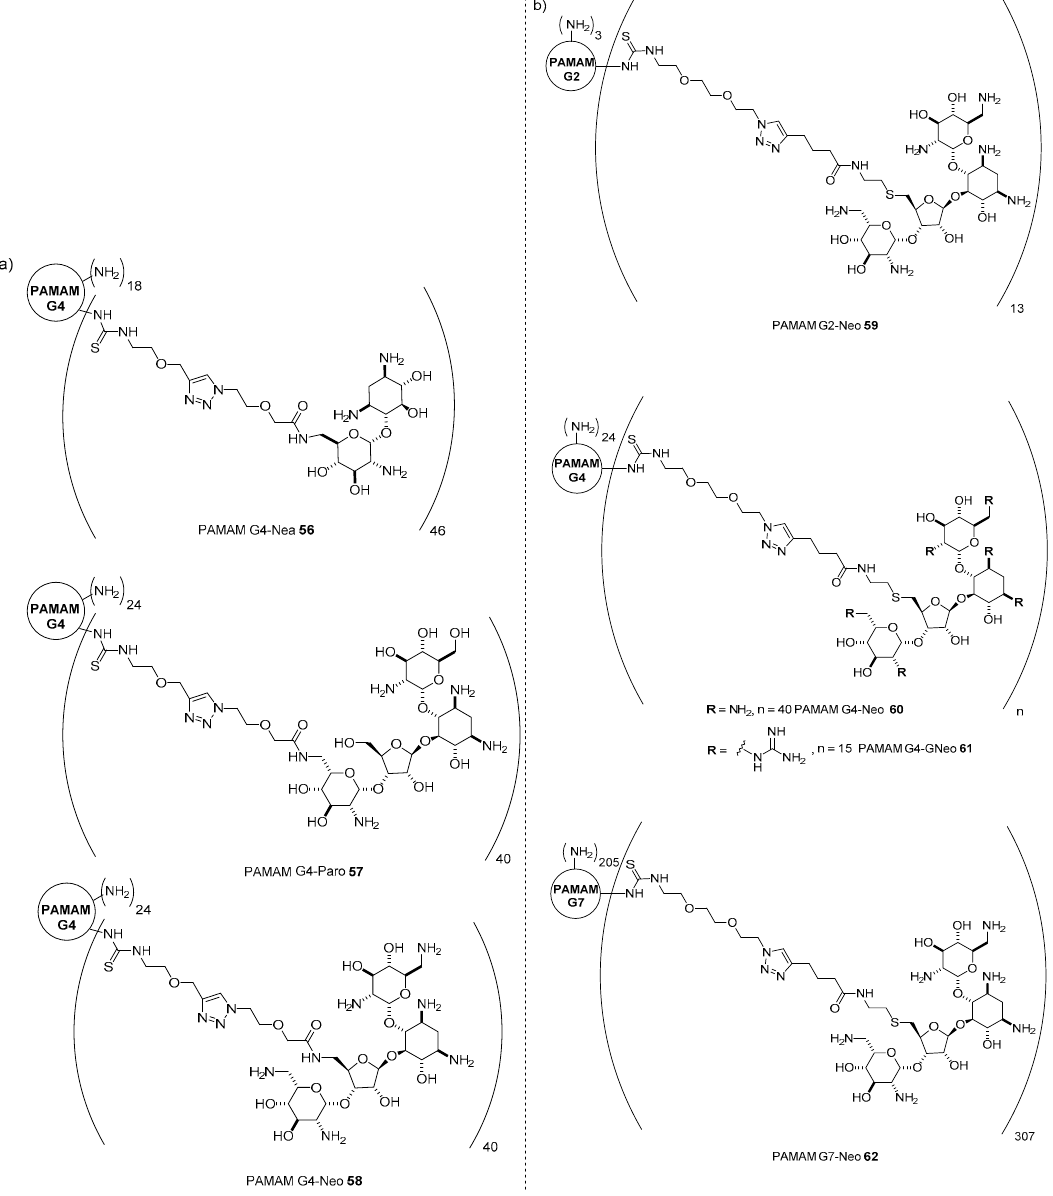
Figure 17. ( a ) Structures of AG-based PAMAM G4 conjugates 56 – 58 and ( b ) structures of neomycin based PAMAM dendrimers of different generations 59 – 62 .